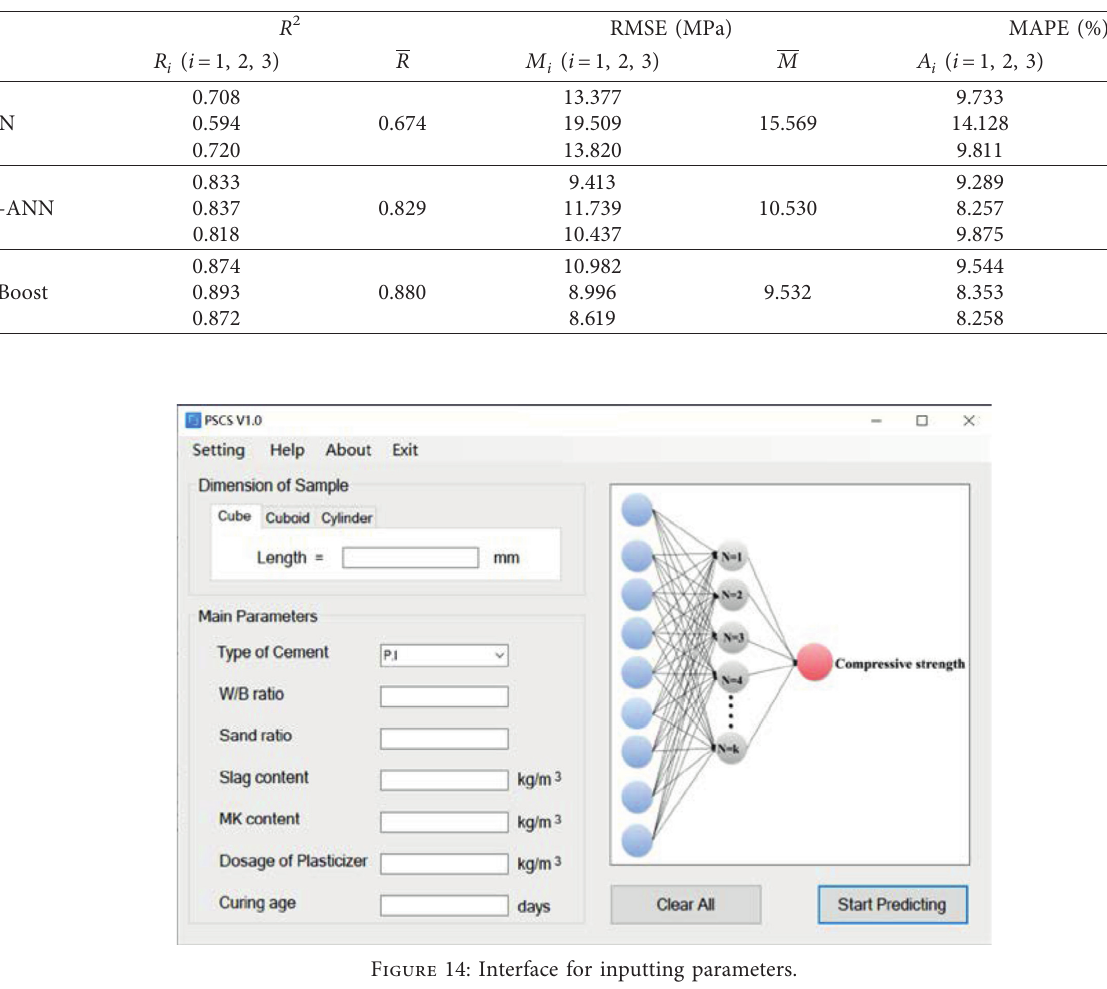
Figure 13: Predictive and true values of ANN, GA-ANN, and XGBoost for dataset 3. Table 6: Individual and average values of the R 2 , RMSE, and MAPE of ANN, GA-ANN, and XGBoost.